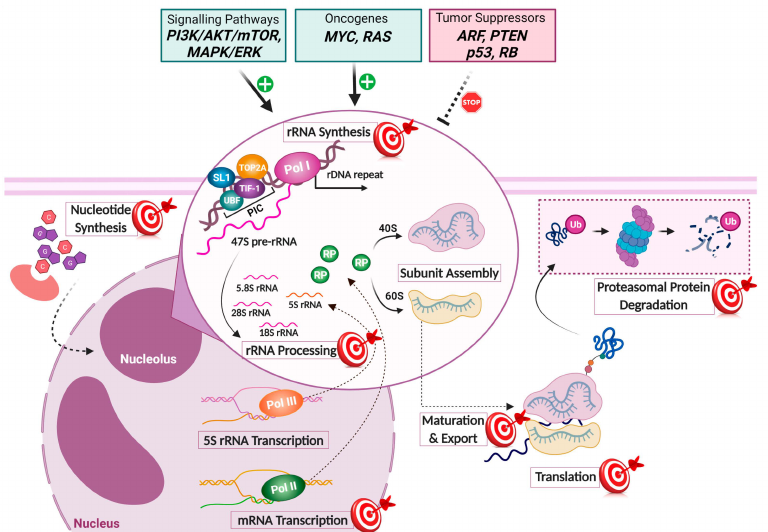
Figure 1. Cellular targets and processes for small molecules that directly, or indirectly, can interfere with ribosome biogenesis. Figure was created with Biorender.com under academic